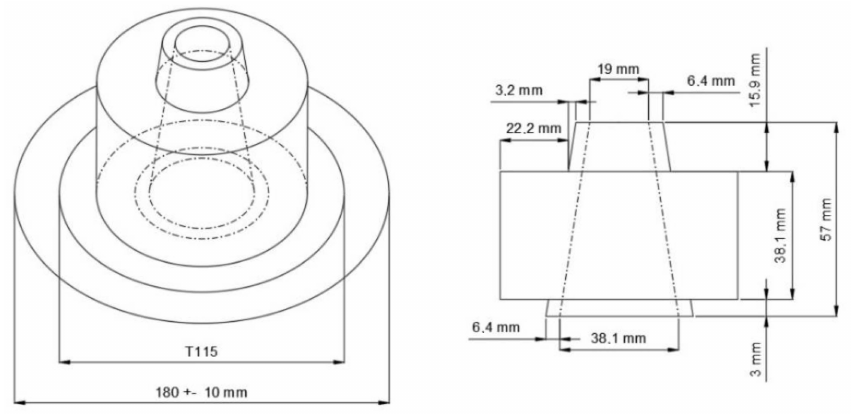
Figure 2. Equipment and illustration of the mini slump test for self-compacting paste. Source: [2].